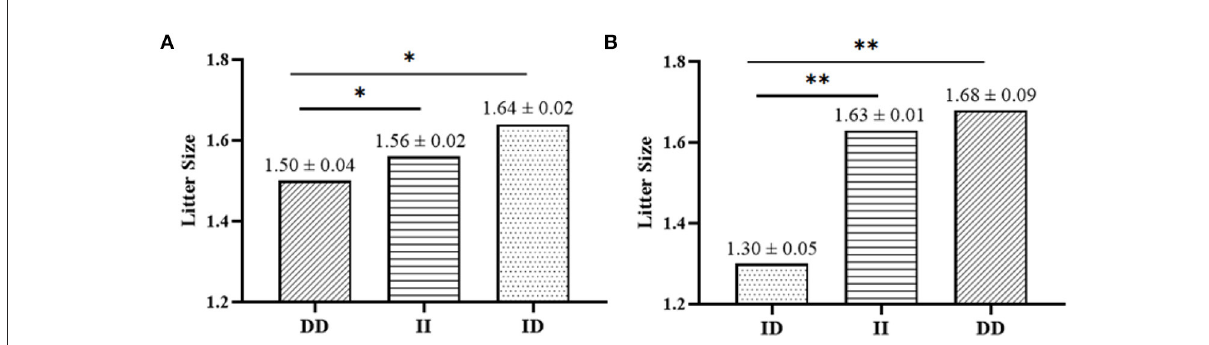
FIGURE4 Association analyses between litter size and the two InDels in SBWC goats; (A) P1-Del-17bp, (B) P2-Del-20bp. * means P < 0.05; ** means P < 0.01.